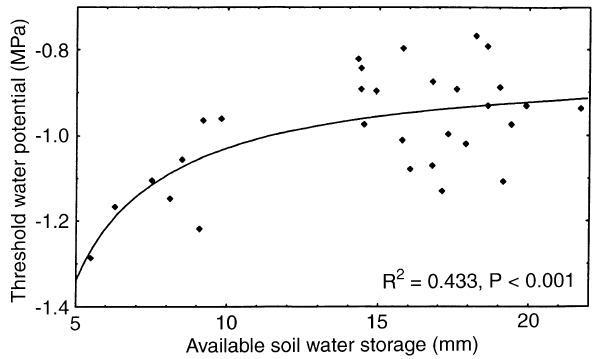
Fig. 6. The threshold values of the shoot water potential inducing a stomatal closure at midday versus available soil water storage at the depth of